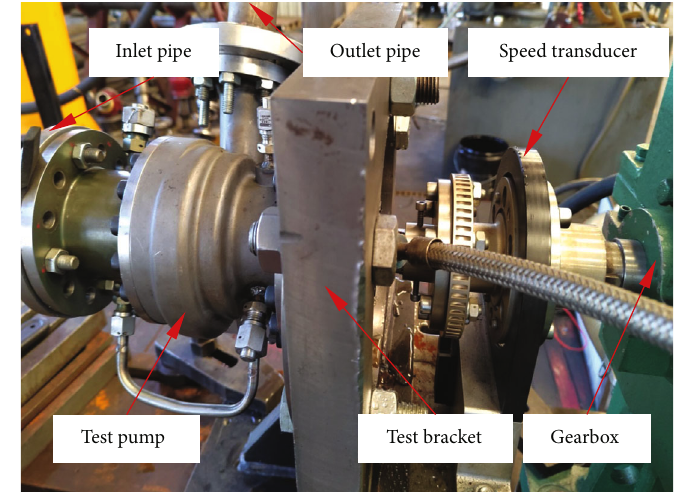
Figure 2: Schematic of the experimental test rig.